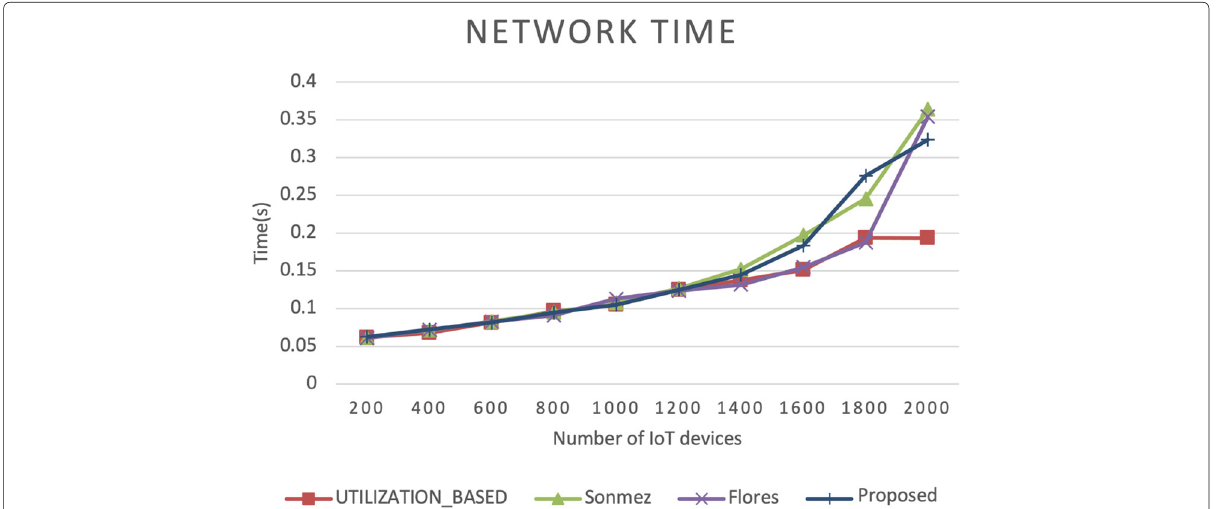
Fig. 9 The network time of the proposed approach with other related